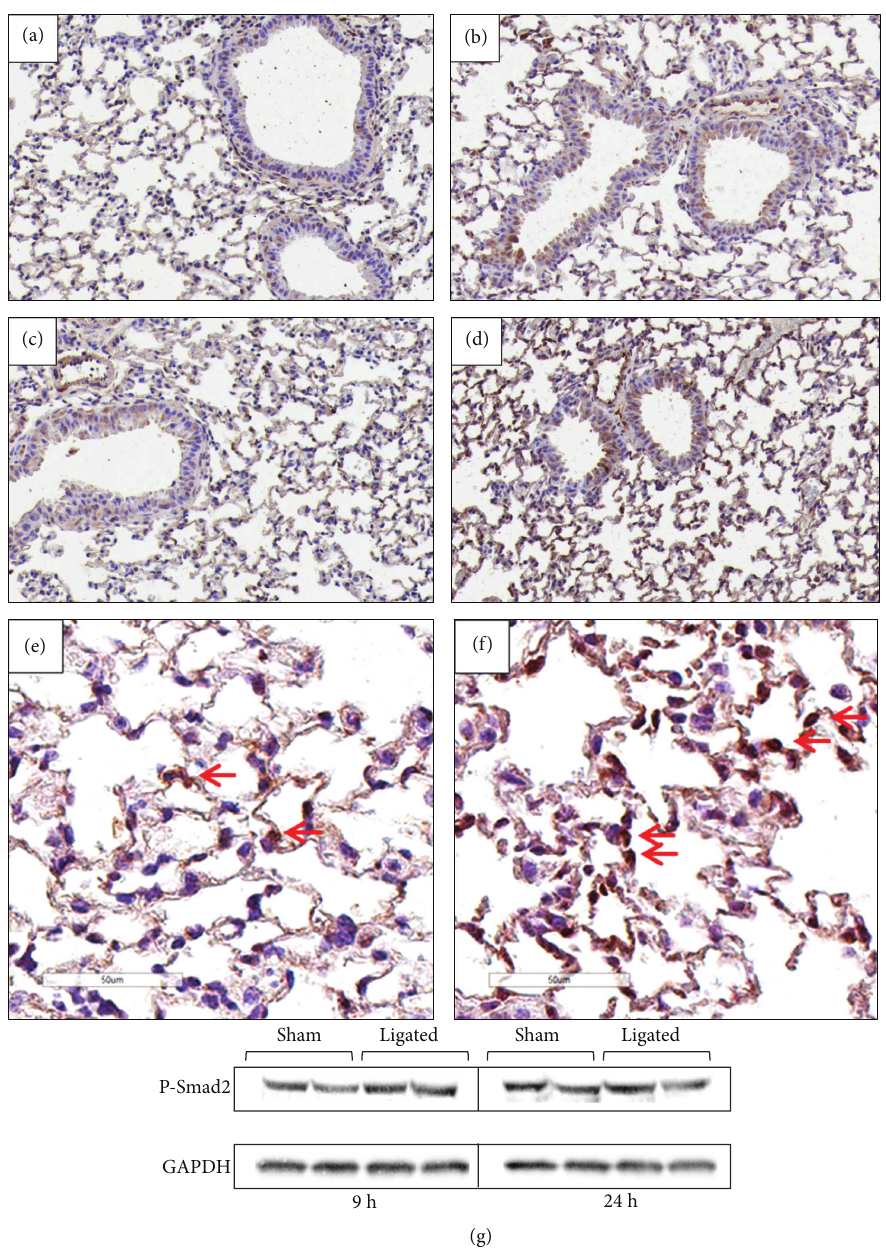
Figure 5: Redistribution and nuclear translocation of P-Smad2. Representative images of P-Smad2 in lung tissue at 9 h (a and b) and 24 h (c and d) following sham operation (a and c) and acute pancreatic induction (b and d). Original magnification, × 20. Arrows indicate nuclear translocation of P-Smad2 after 24 h in the ligated animals (f). More cytoplasmic (arrows) and less nuclear staining of P-Smad2 were observed in the sham-operated group (e). Original magnification, × 40. Results from one representative of eight samples per group are shown. Western blot analysis of total P-Smad2 protein levels in lung extracts of sham-operated and ligated animals (g). Two of five similar analyses per group are